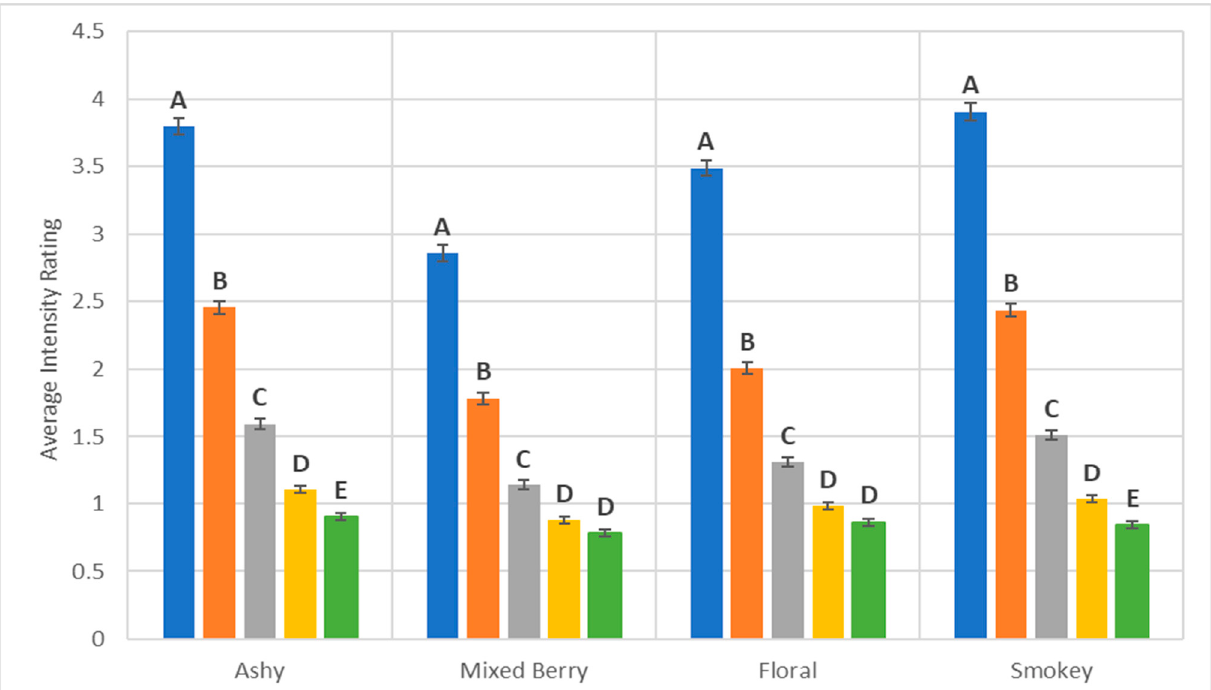
Figure 3. The average intensity of all wines and rinses at 0 s (blue), 30 s (orange), 60 s (grey), 90 s (yellow), and 120 s (green). The same letter above the bars indicates no statistical difference ( α = 0.05) between average intensity ratings at each time point within each attribute, as determined by Tukey HSD comparison of means. Error bars represent standard error of the means.